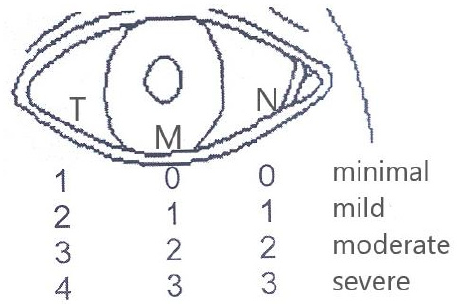
Figure 1. CCH grading.